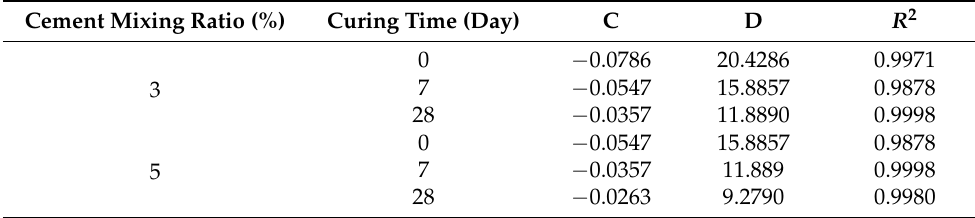
Table 2. Fitting coefficients of D m varying function with λ .